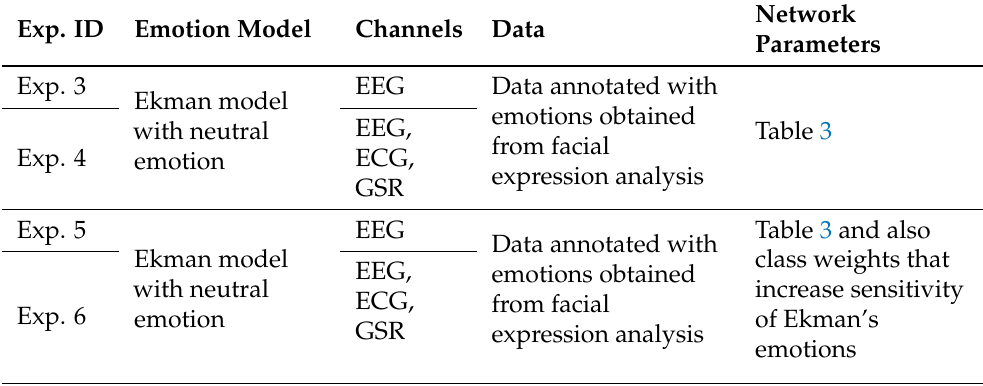
Table 9. Specification of